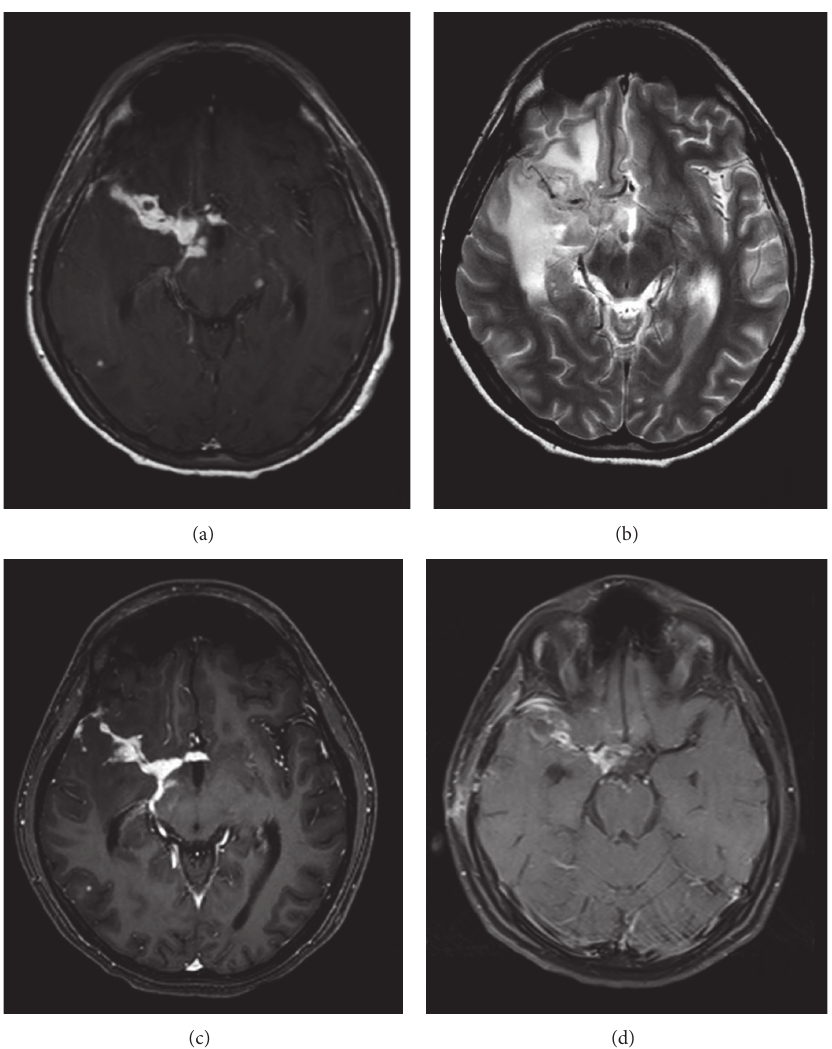
Figure 3: Contrasted T1A (a) and T2A (b) images 60 days after the diagnosis, contrasted T1A (c) image of 75 days later, and contrasted T1A (d) image of 90 days after the diagnosis. Considerable progression of the basal meningitis and parenchymal tuberculomas was seen after the 60th day instead of tuberculosis regression (a, b). A contrast is seen in the scattered parenchymal tuberculoma (a). After this examination, the patient began taking a steroid. There is a reduction of the basal meningitis and tuberculoma at the contrasted T1A image after 15 days on the steroid treatment. (c) A disappearance of tuberculomas, regression of contrast involvement, and exudate on the right sylvian fissure are seen on the contrasted T1A image 30 days after the steroid